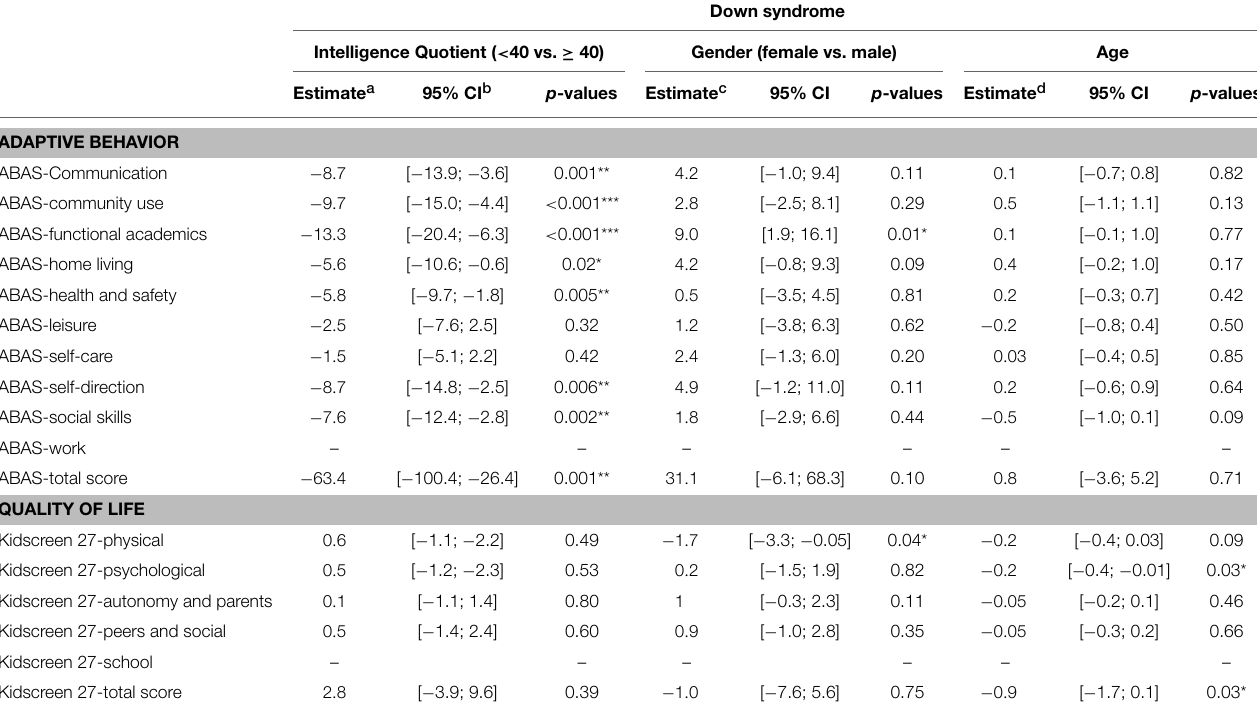
TABLE 5 | Impact of intellectual quotient (IQ), gender, and age on functional outcomes in Down syndrome